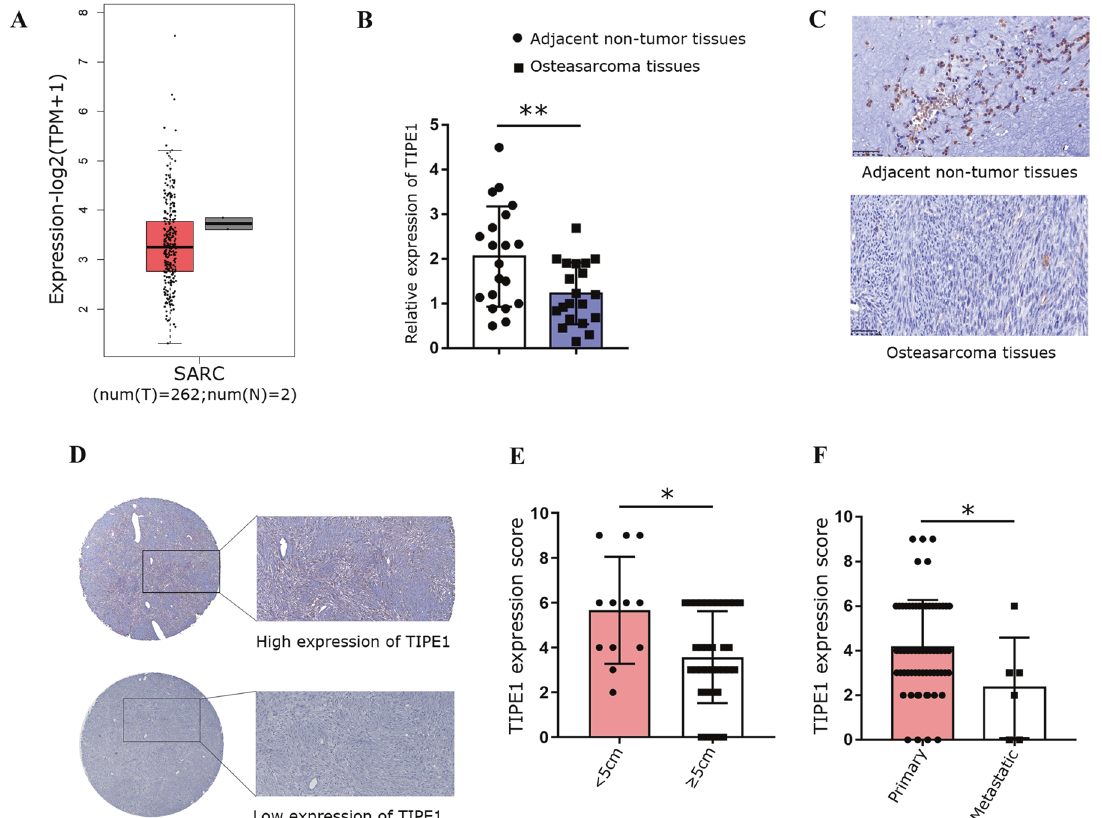
Fig. 1 TIPE1 expression is down-regulated in osteosarcoma tissues and predicts a poor prognosis. A The level of TIPE1 expression in SARC tissues was lower than that in normal tissues in TCGA dataset. B , C The level of TIPE1 expression in osteosarcoma tissues was lower than that in adjacent nontumor tissues according to immunohistochemical staining. D The expression of TIPE1 in osteosarcoma tissue chips as shown by immunohistochemical staining. E Osteosarcoma patients with lower levels of TIPE1 were prone to developing large tumors by using immunohistochemical staining. F Osteosarcoma patients with lower levels of TIPE1 were more likely to have tumor metastasis by using immunohistochemical staining. ** P < 0.01, * P < 0.05. The data represent the means ±